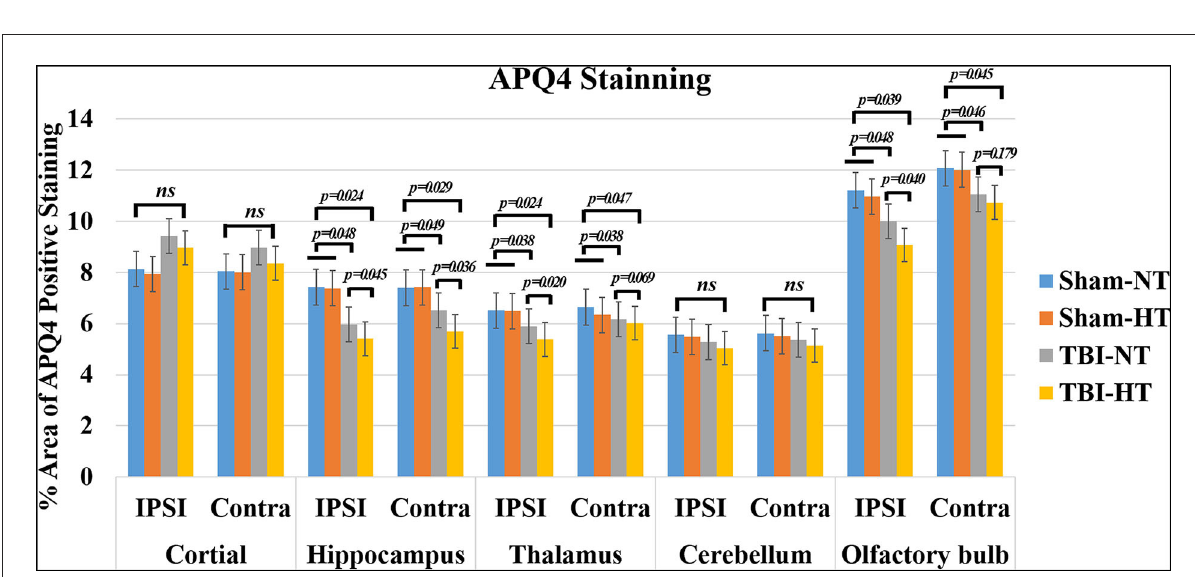
FIGURE11 Quantification of bilateral, subregional APQ4 immunoactivity from sham, TBI-NT, and TBI-HT. The density of subregional AQP4 immunostaining is expressed as a percentage area of the subregion. Significantly decreased AQP4 expression, determined by mean positive area, was identified in all subregional brains in TBI-HT rats, compared with TBI-NT rats, and in TBI rats, compared with sham rats. Note: ns indicates no significance. Data in Figure 11: Sham-NT n = 6, sham-HT n = 6, TBI-NT n = 8, TBI-HT n = 8, pooled data from four independent experiments. All n values refer to the number of rats used, and the error bars depict the mean ± s.e.m. P -values were calculated by one-way ANOVA with Bonferroni’s multiple comparison test, and P < 0.05 indicates significance. Contra, contralateral hemisphere; IPSI, ipsilateral hemisphere.